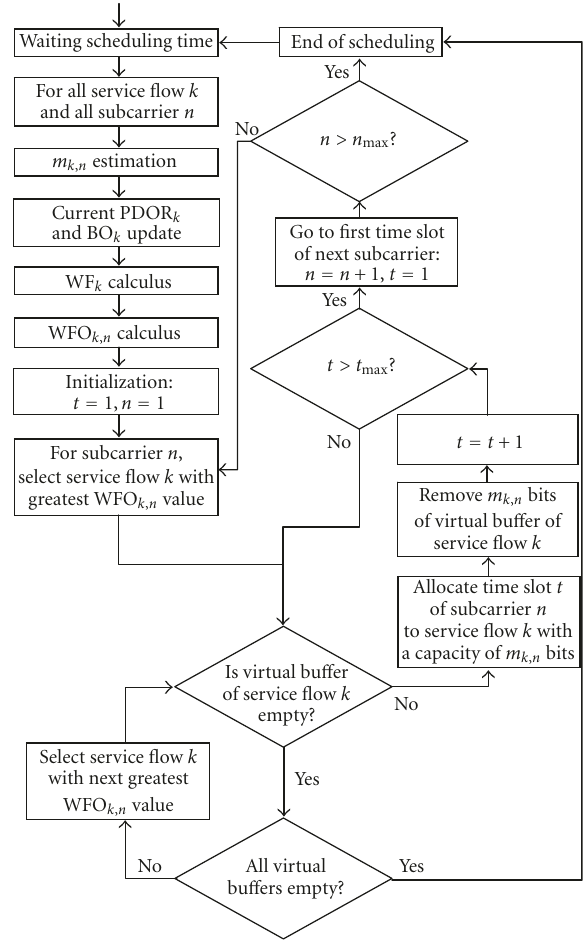
Figure 6: WFO scheduling algorithm flow